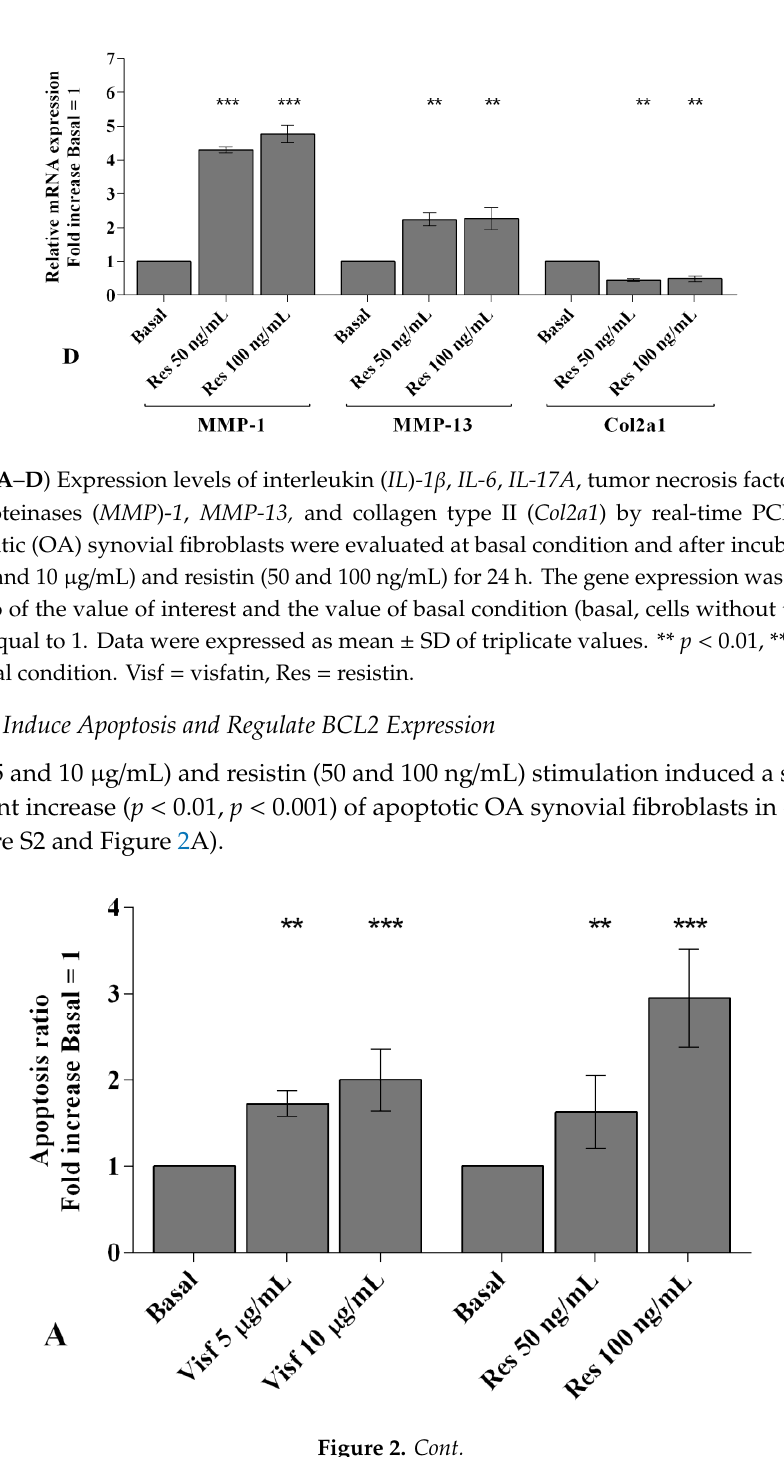
Figure 1. ( A – D ) Expression levels of interleukin ( IL ) -1β , IL-6 , IL-17A , tumor necrosis factor ( TNF )- α